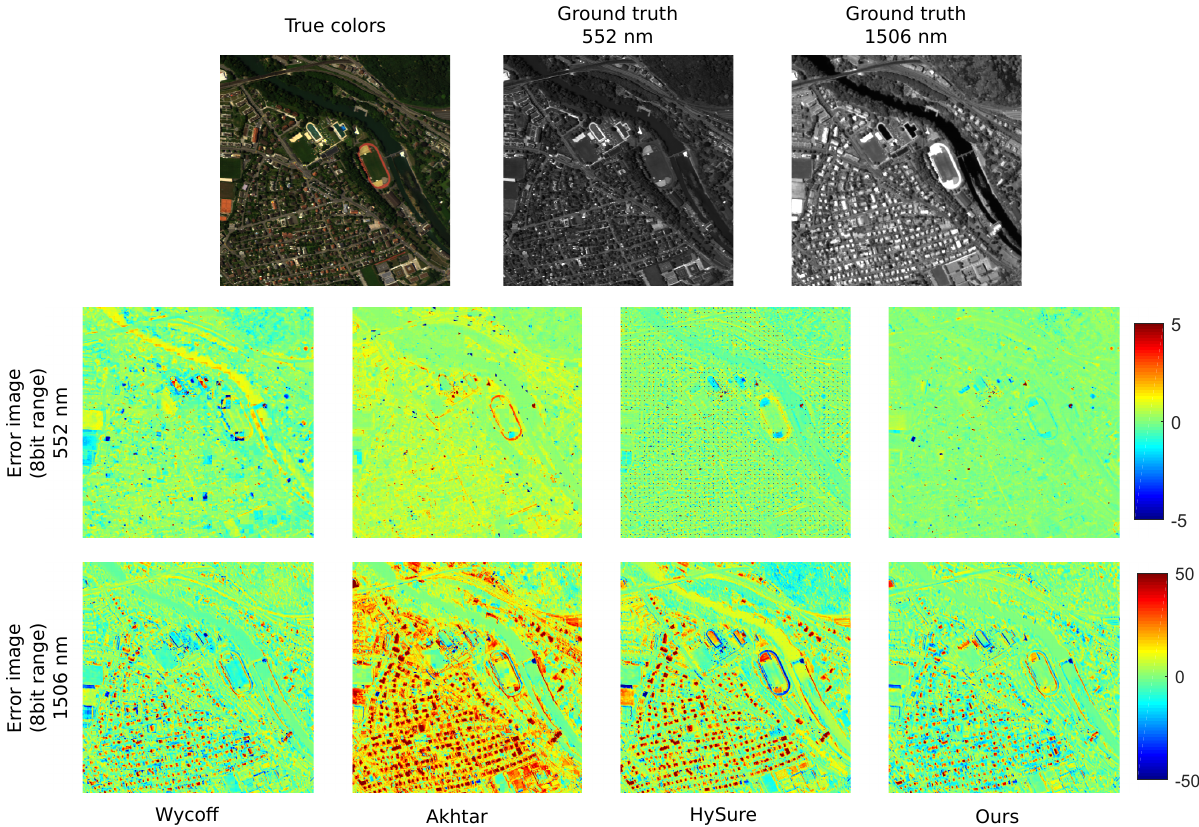
Figure 4. Top row: True color image for APEX and ground truth spectral images for wavelengths 552 and 1506 nm. Second and third rows: The reconstruction error for each method at the mentioned wavelengths. Note the difference in the color scale between the two rows.